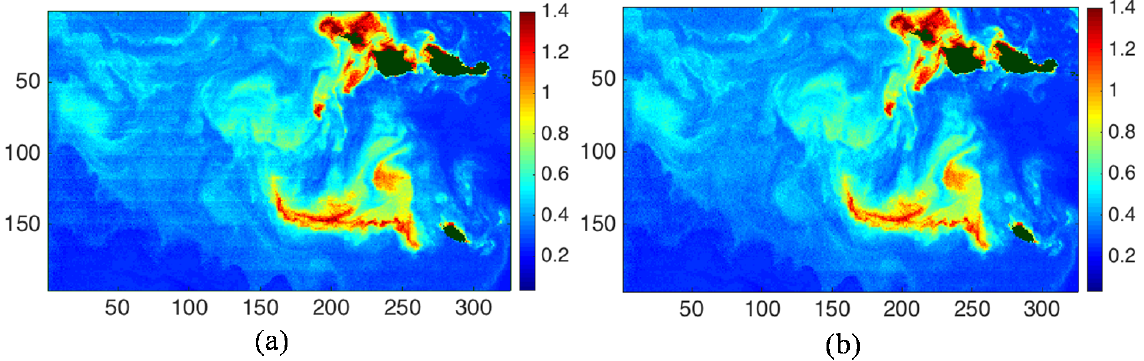
Figure 8. Panel (a) shows the destriped image scene of the panel (a) in Fig. 7 from NASA’s vicarious calibration of The L2 (*.nc) product method. While NASA’s vicarious calibration of The L2 (*.nc) product method does improve over the raw image, there are still stripe artifacts present. The following image (b) represents the destriped image of the image (a) from our method.